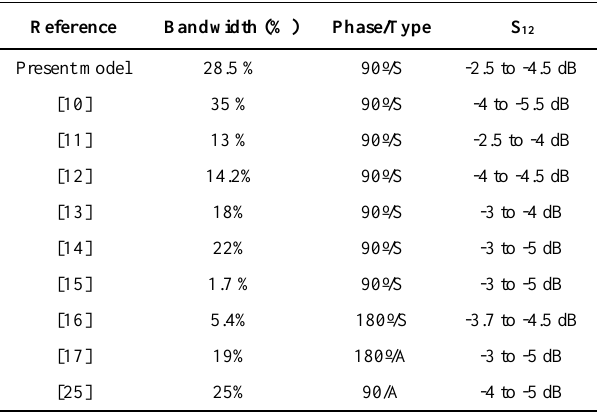
Table2. Comparison of the prototype